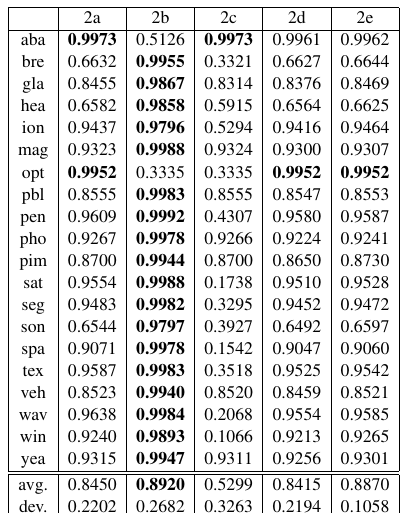
Table 8. Comparison of Pareto fronts using HVR